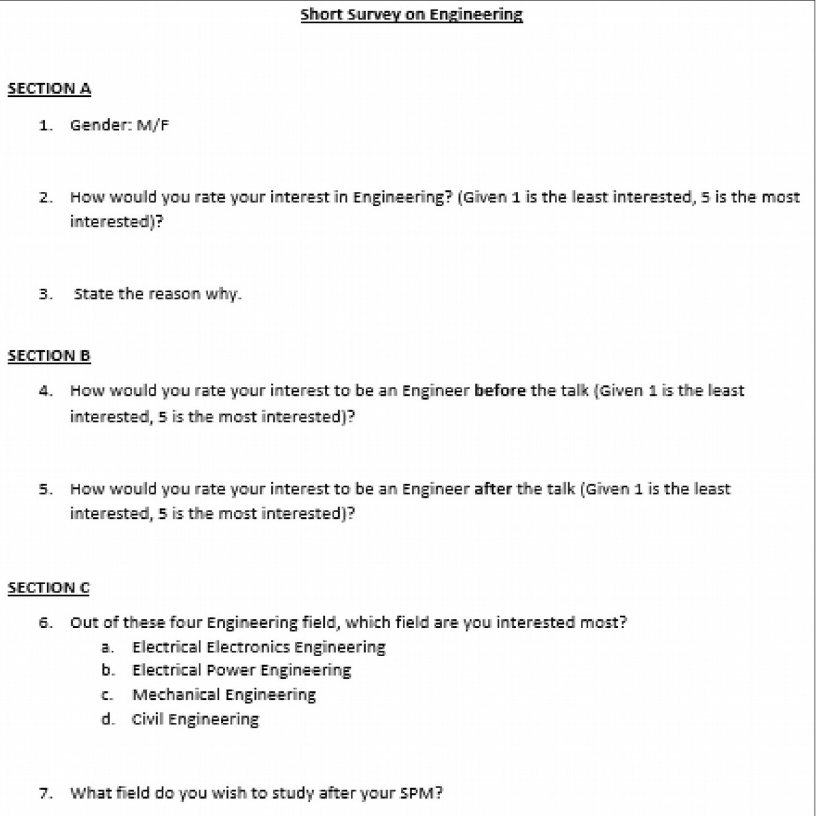
Figure 1. Survey questions